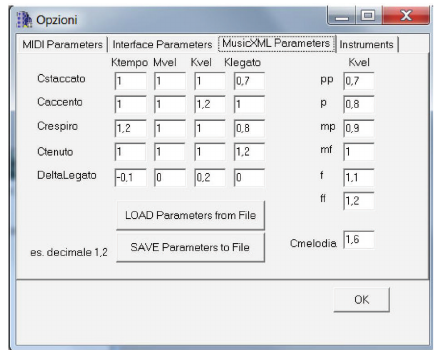
Figure 8: A control space designed for an educational context. The position of the emoticons follows the results of [37].